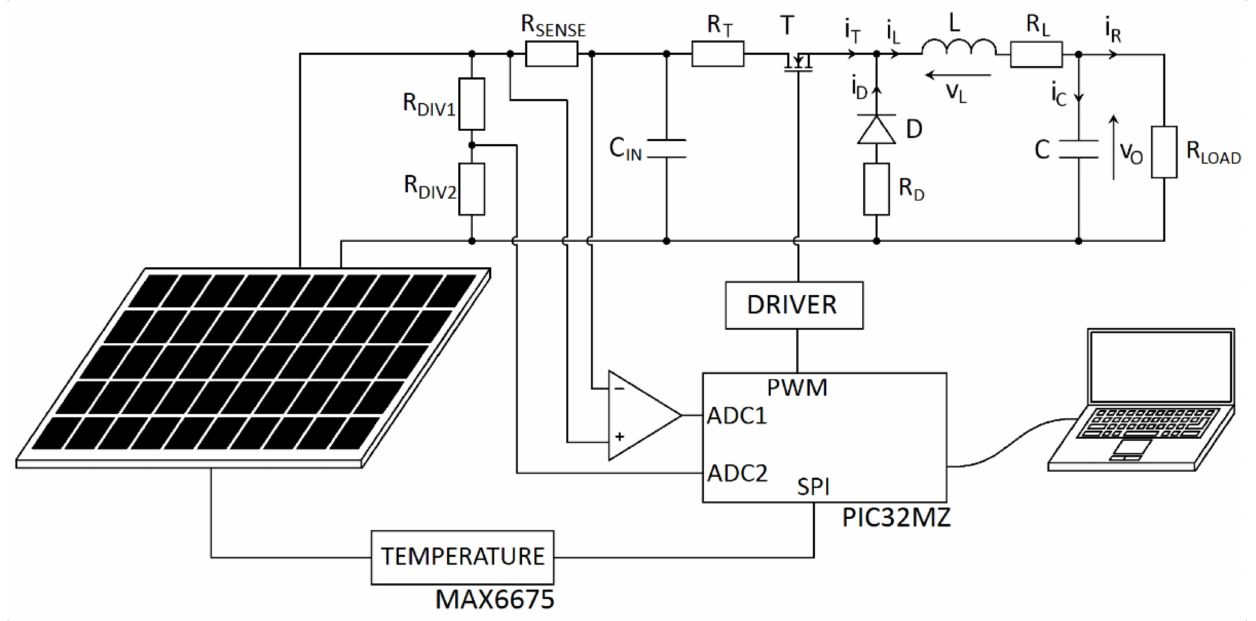
Figure 5. A dedicated system for the measurement of the I-V characteristics of a photovoltaic panel and searching for the maximum power point